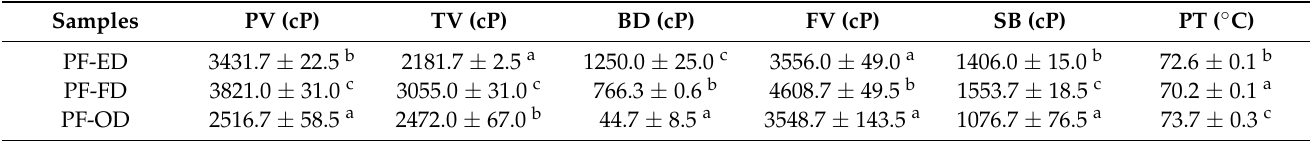
Table 3. Pasting properties of potato flours.